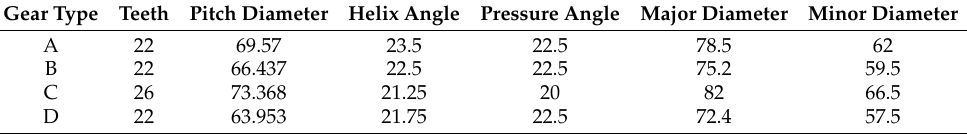
Table 1. Characteristics of the four types of gears produced by the factory in Guelph, Ontario [1]. Diameters and angles are in mm and degrees, respectively.